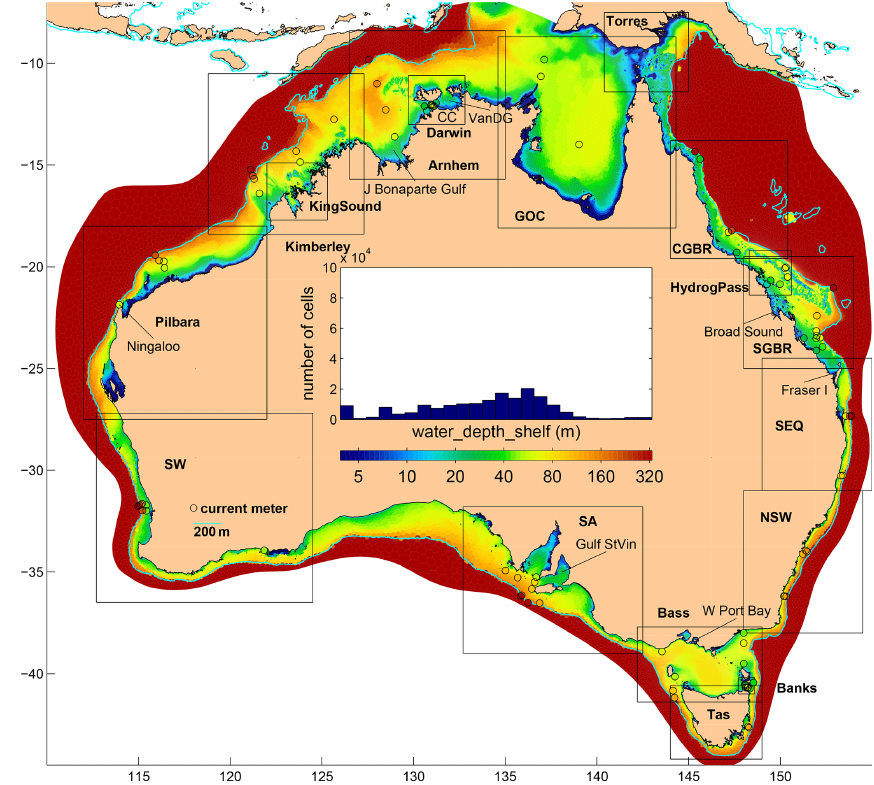
Figure 2. Model depth (m, log scale, spanning just a restricted range); otherwise like Fig.